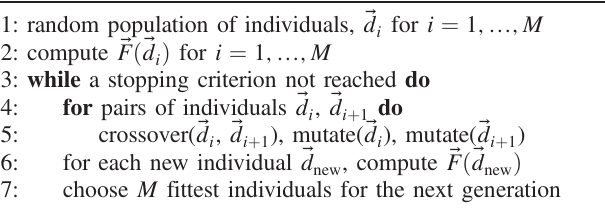
Algorithm 1. Multiobjective genetic